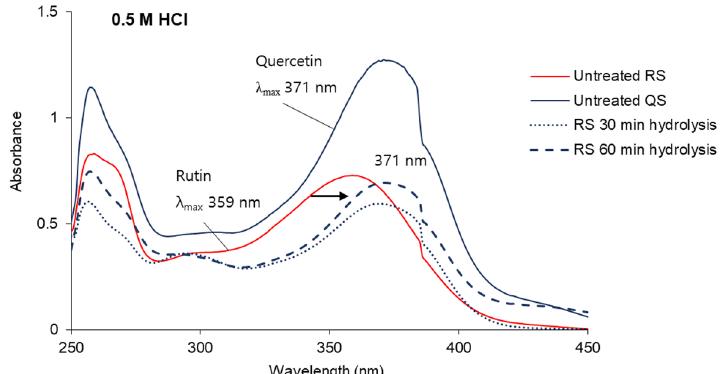
Fig. 5 UV spectra of Rutin standard (RS) hydrolyzed with 0.5 M HCl and Quercetin standard (QS)